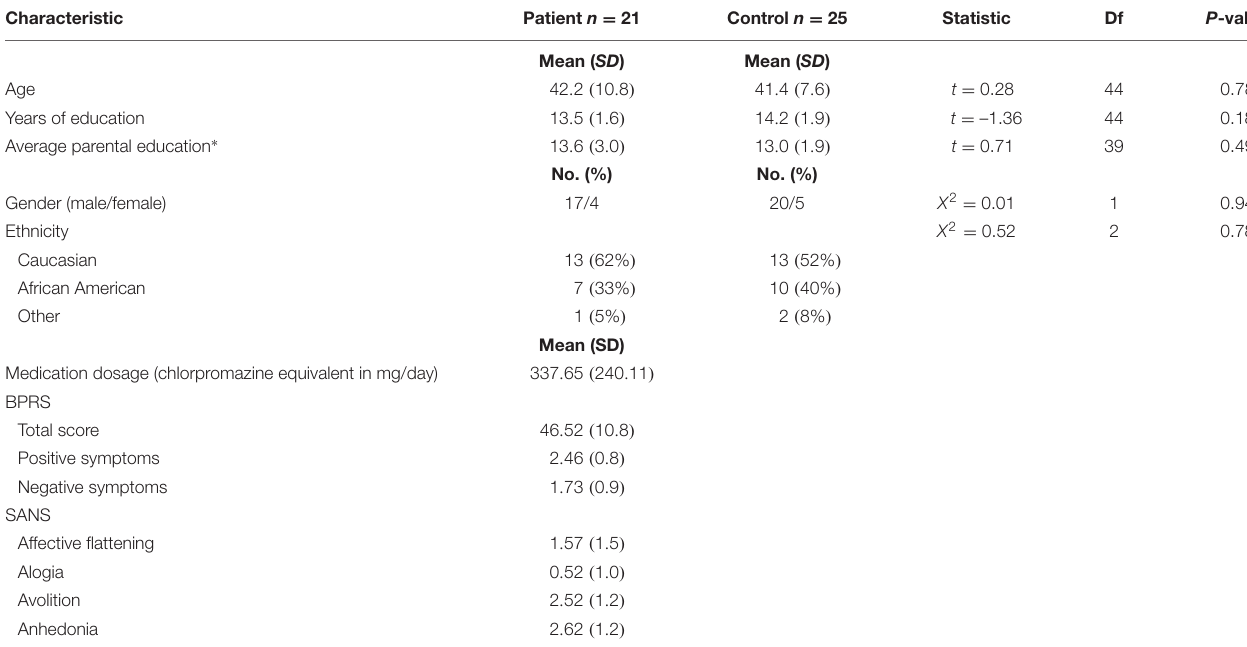
TABLE 1 | Sample demographic and clinical